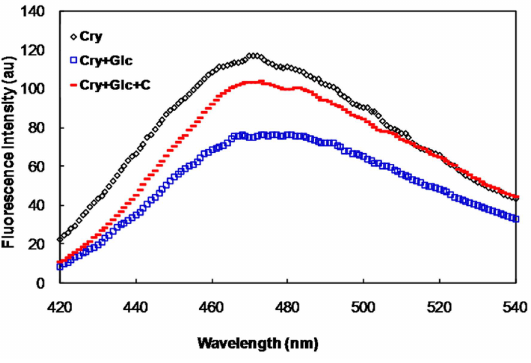
Figure 2. ANS fluorescence of α -crystallin, in the presence of 500 mM of glucose with and without crocin(s).